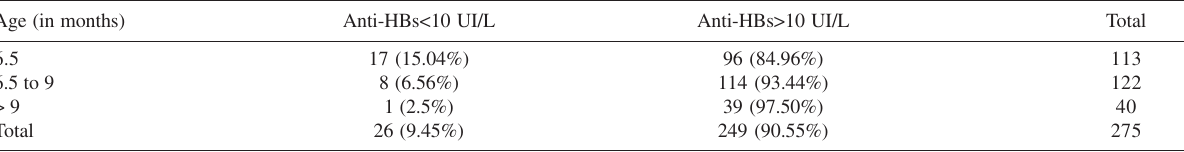
Table 2 - Seropositivity to anti-HBs for the 3 groups of children studied Age (in